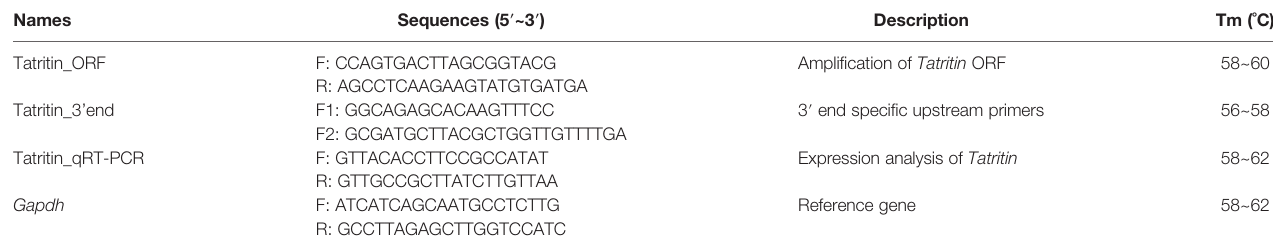
TABLE 1 | Primers used for ampli fi cation of Tatritin and qRT-PCR in this